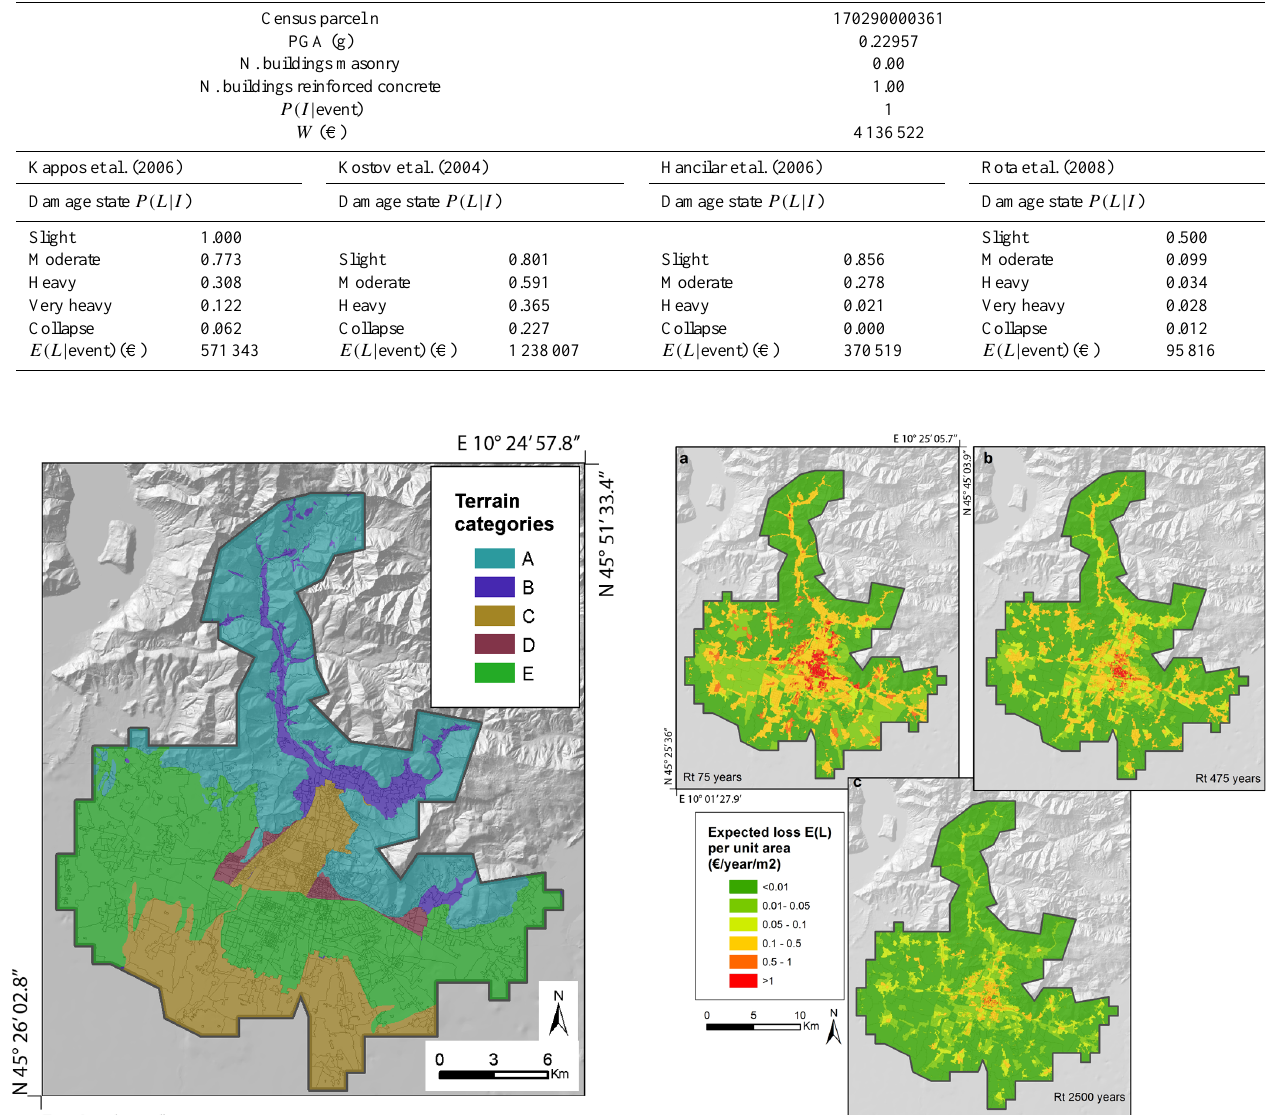
Table 5. Example of calculation of seismic vulnerability of a census parcel containing one 1-floor non-residential building shaken by a T r 475yr earthquake.